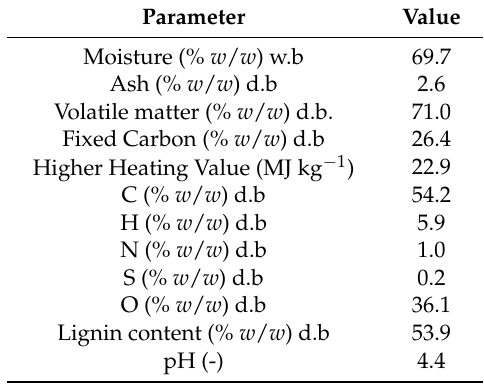
Table 2. Characterization of the lignin-rich stream (w.b.: wet basis; d.b.: dry basis).